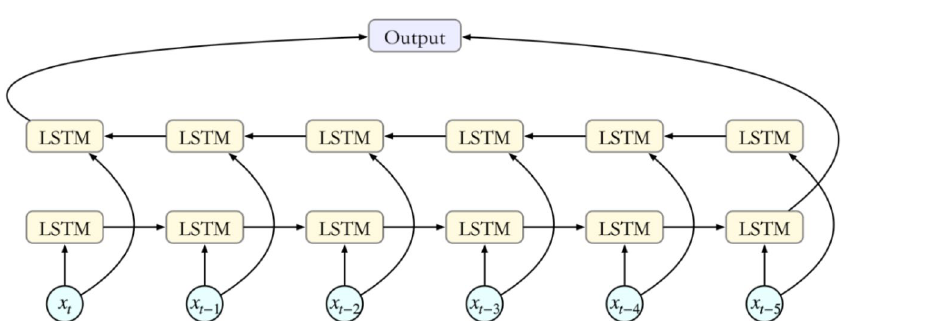
Figure 3. Residual block structure.